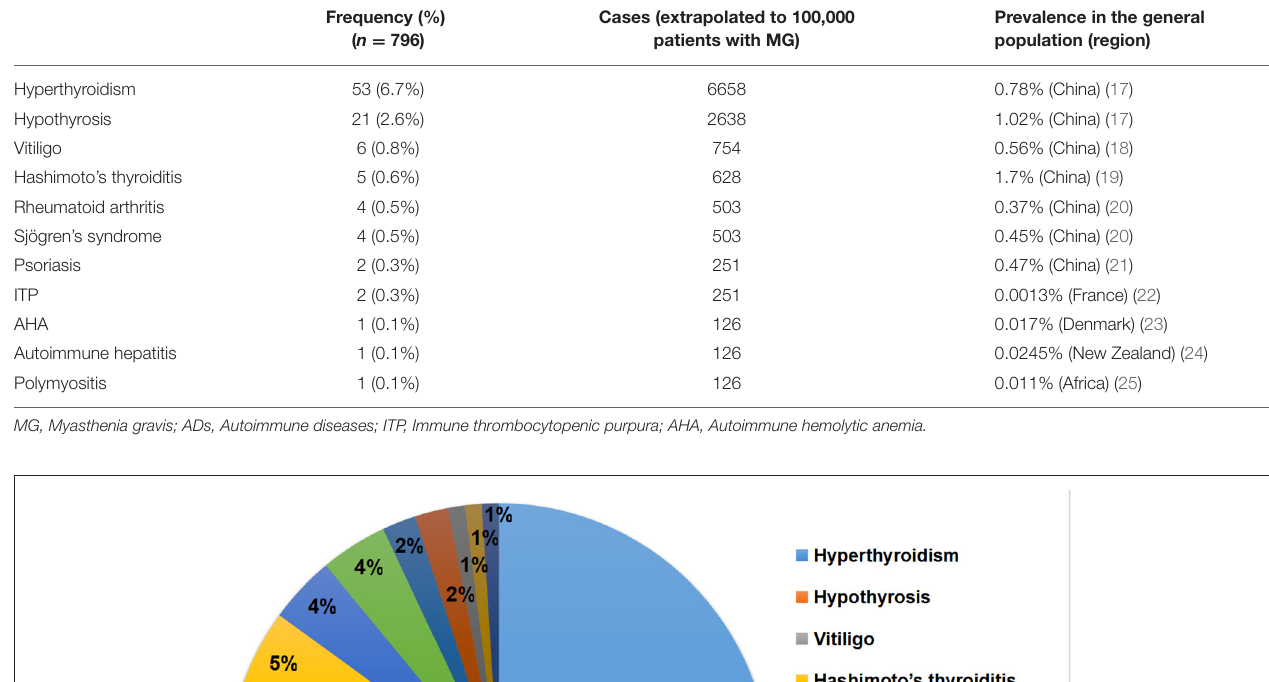
Cases (extrapolated to 100,000 patients with MG)